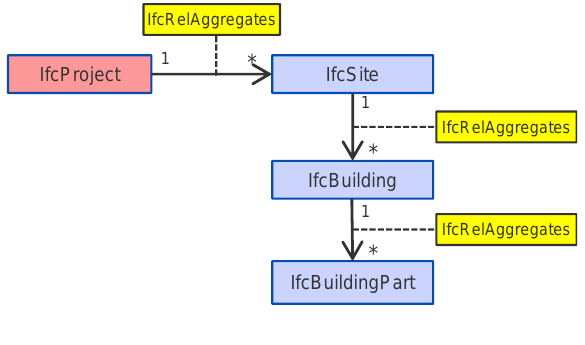
Figure 6. Modeling of spatial structures in IFC